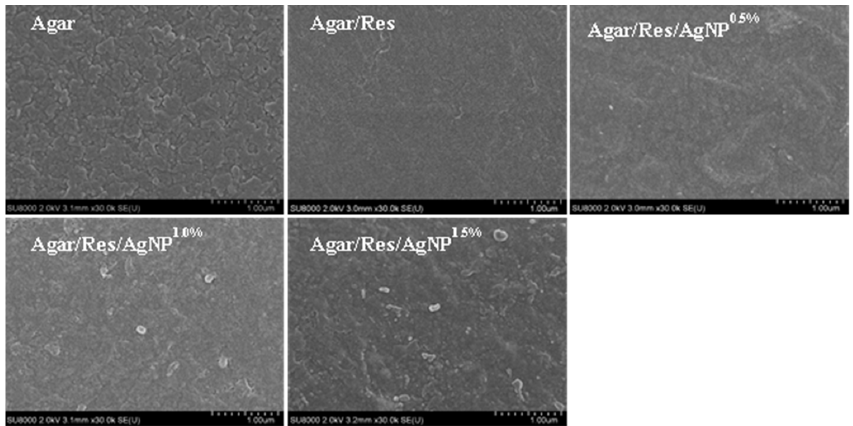
Figure 2. SEM images of the agar-based composite films.